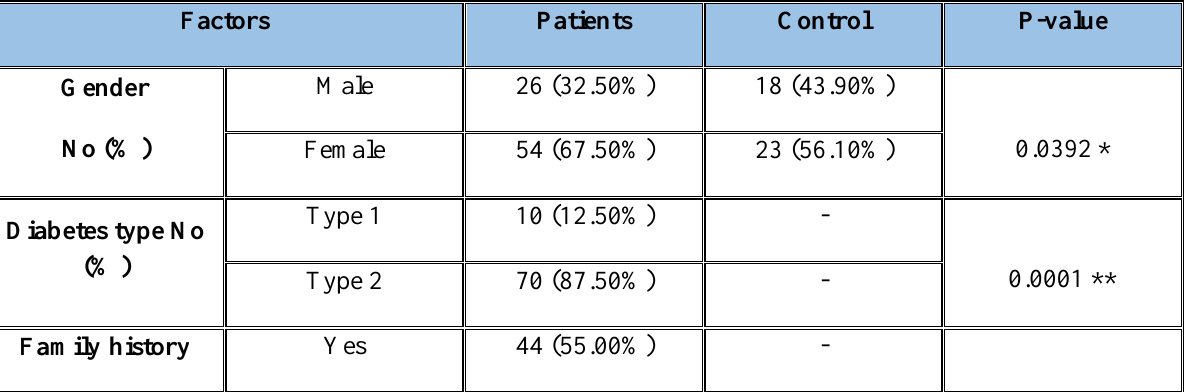
Table 7: Results of factors in sample